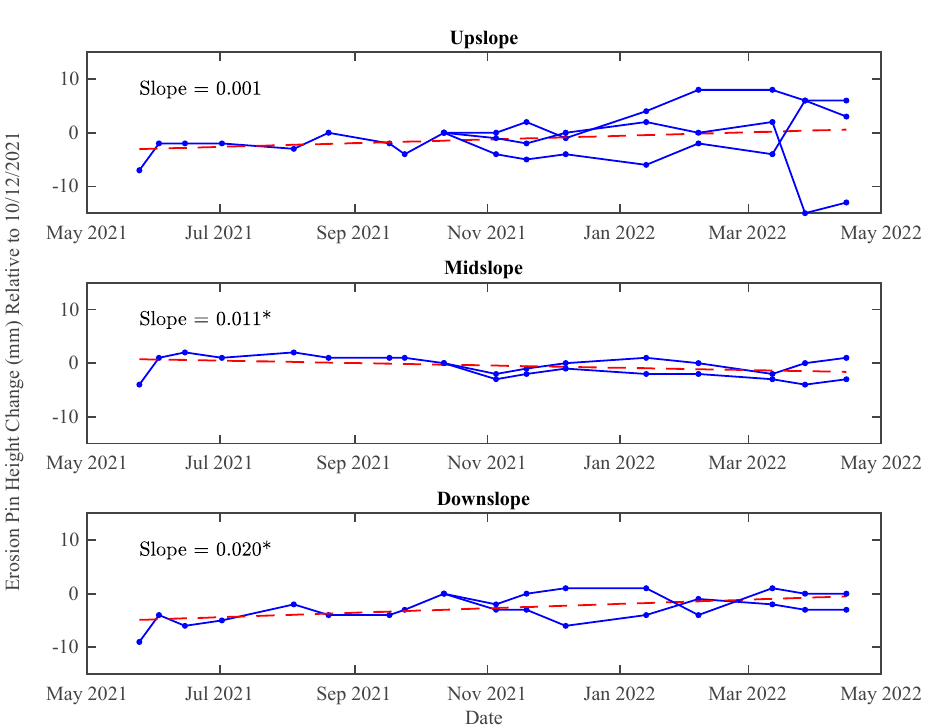
Figure 8. Linear regression for the plot with vetiver between time in days and erosion pin height relative to the measurement on 12 October 2021, when all erosion pins were installed and stabilized. Solid blue lines and markers show the trajectory of measurements for each erosion pin and dashed red lines show the regression line. Regression slope is given in each plot with * indicating a regres- sion p -value less than 0.1. Regression lines are calculated separately for upslope ( top ), midslope ( middle ), and downslope ( bottom ).